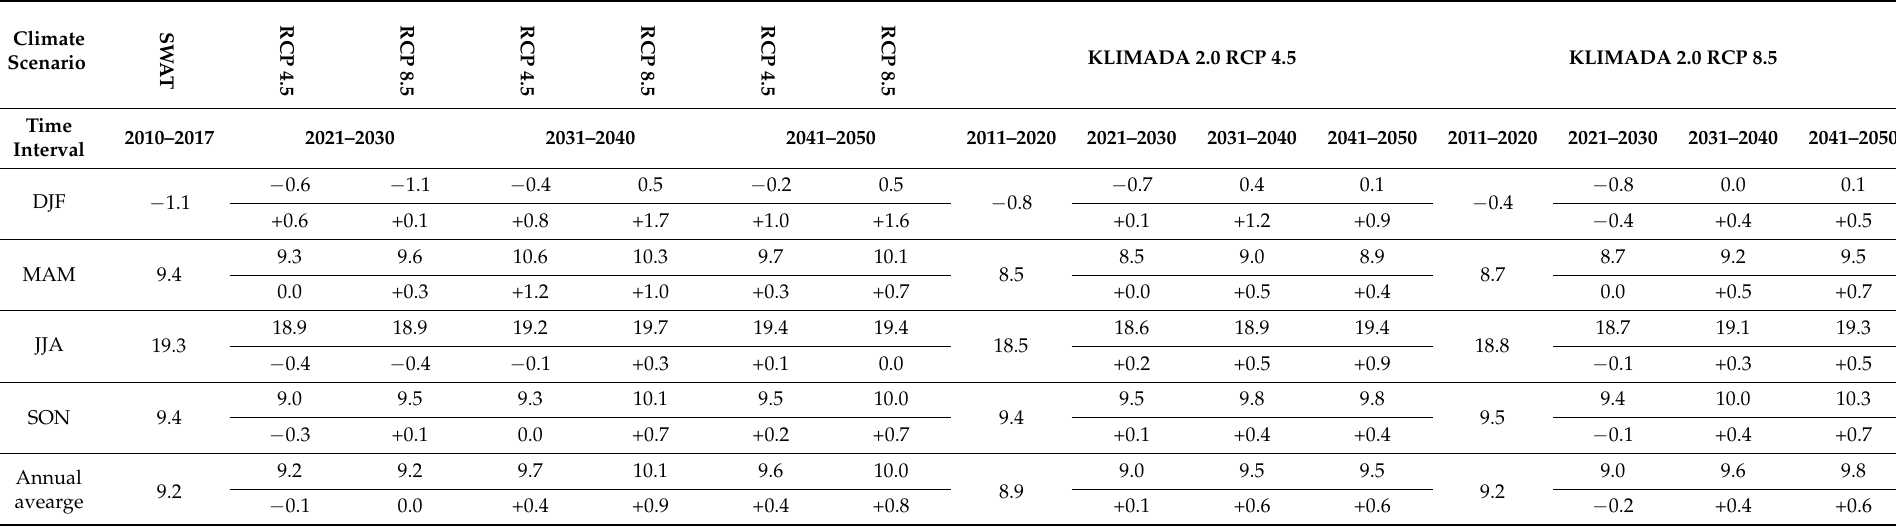
Table 12. Comparison of the average temperature distribution in the seasons for the SWAT simulation period 2010–2017 with individual forecasts for the RCP